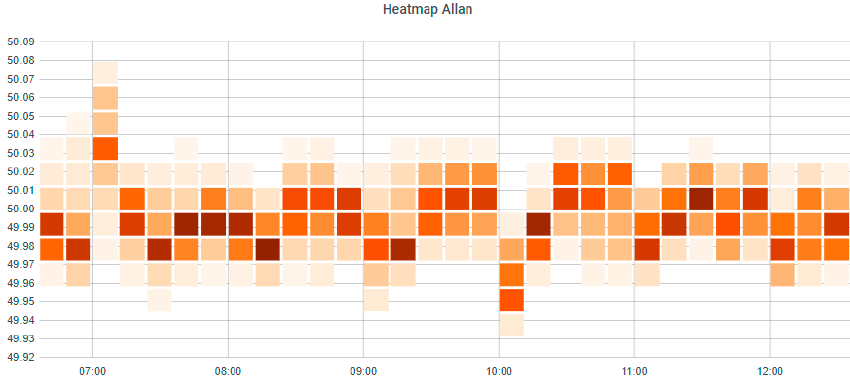
Figure 12. Heatmap of Allan-based frequency measurements. The horizontal axis corresponds to the timescale. Figure 12 is divided into one-hour intervals. Each interval contains five columns of squares, so each column corresponds to an interval of twelve minutes. The vertical axis corresponds to the frequency scale. As the Allan frequency is measured each second and each square in column corresponds to twelve minutes, for each column we have 720 measurements. To indicate the distribution of these measurements, in each column there are various squares of different colors. The darker the square, the more measurements have been recorded within the considered frequency interval. It can be observed that data continuously fluctuate around 50 Hz. The rest of the measurements are assumed to be outliers, as observed in fluctuations that fall outside the frequency range of 49.95–50.03 Hz, approximately.